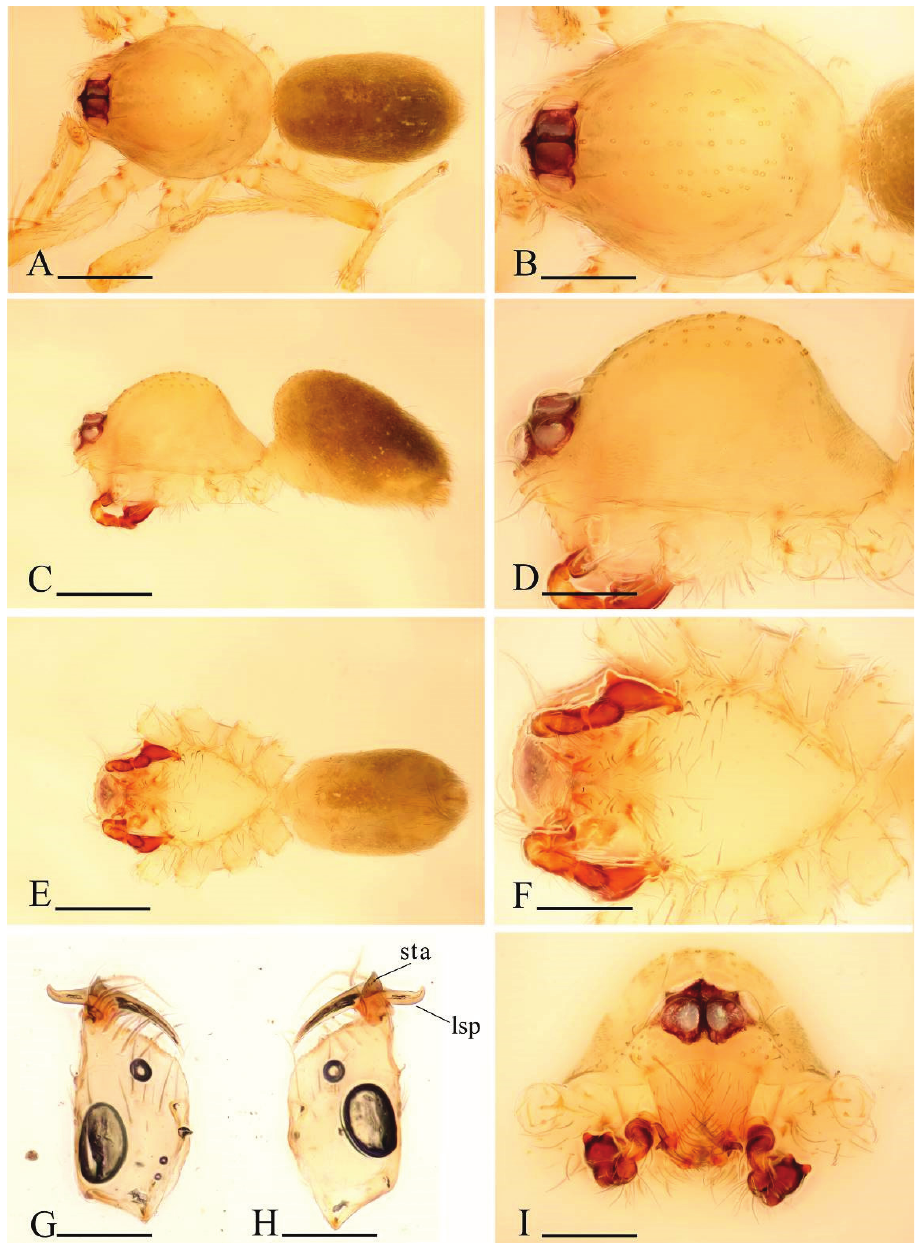
Figure 10. Ischnothyreus poculum sp. n., male. A, C, E habitus, dorsal, lateral and ventral views B, D, F, I prosoma, dorsal, lateral, ventral and anterior views G, H left chelicerae, anterior and posterior views. Abbreviations: lsp = long sclerotized process; sta = sclerotized triangular-shaped apophysis. Scale bars: A, C, E = 0.4 mm; B, D, F, I = 0.2 mm; G, H = 0.1